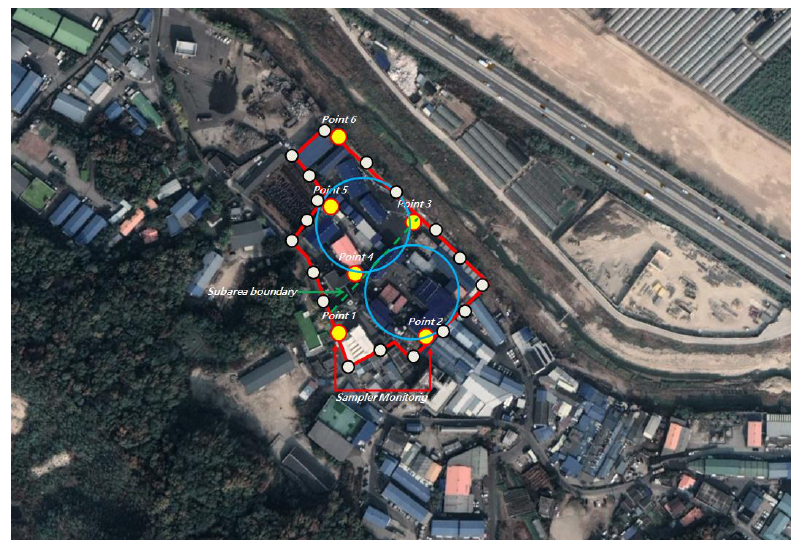
Figure 2. Angular approach: a facility with two divisions (Paint Manufacturing Plant “B”).